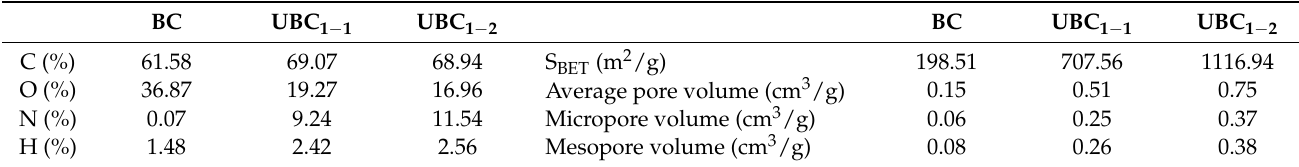
Table 1. Physicochemical characteristics of biochars.